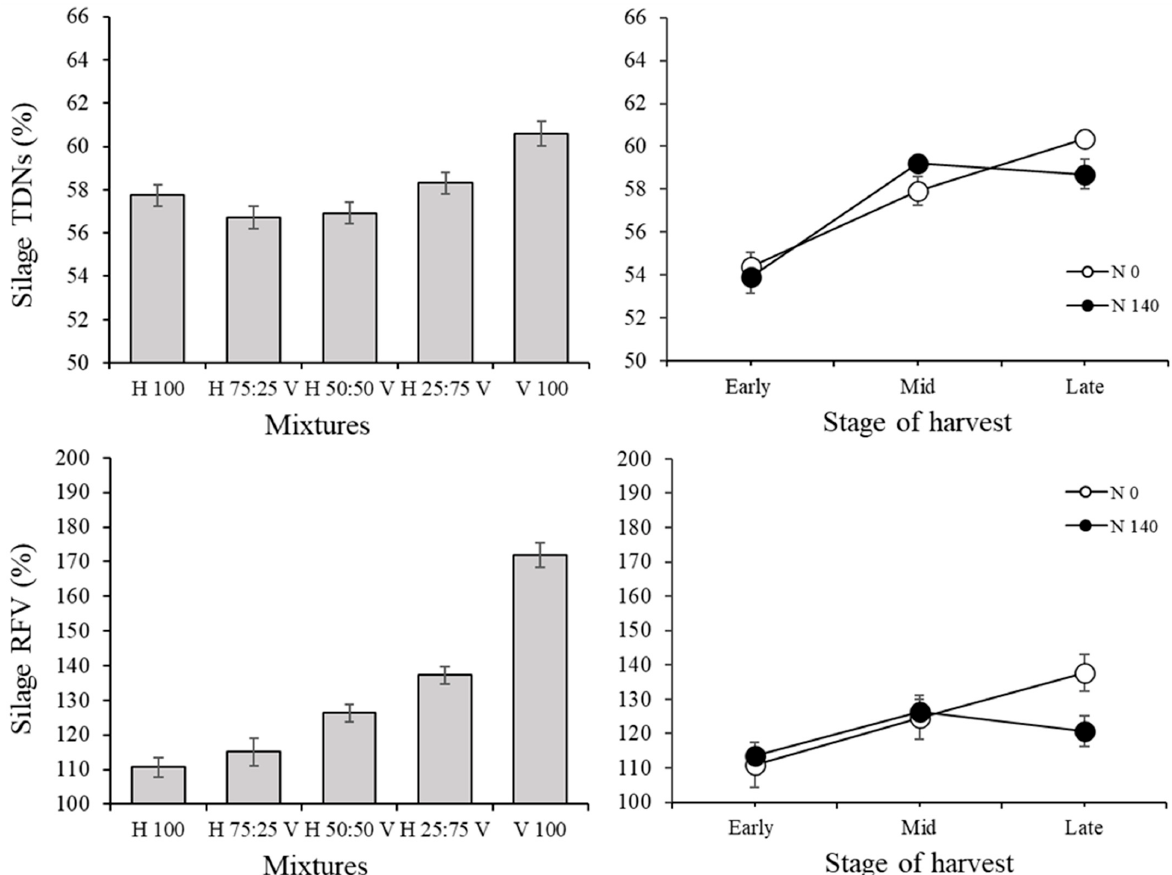
Figure 12. Silage TDN concentration ( above ) and RFV ( below ) as affected by MX mean effect ( left ) and SH × NF interaction ( right ). On the left, values are LSmeans across all treatments along with standard error estimate of the LSmeans since the design was unbalanced between the faba bean crop ( n = 9) compared to the mixtures and the barley crops ( n = 18). On the right, only data of the barley-containing treatments were used. Each point represents the arithmetic mean ( n = 24) and its computed standard